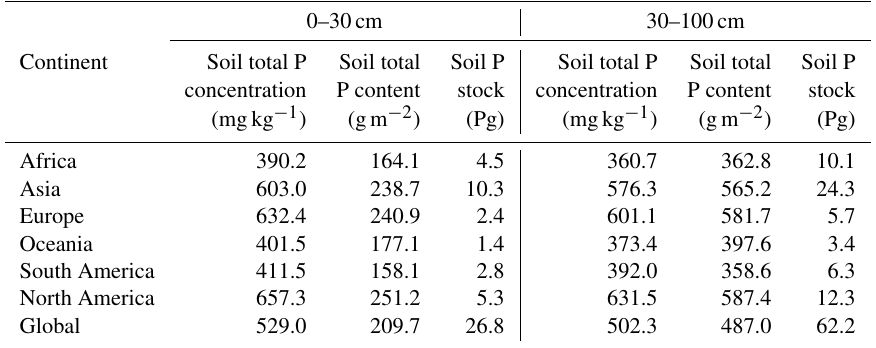
Figure 3. Results of the random forest model predicting soil total P concentration. (a) The relative importance of predictors in the model. (b) Predicted vs. observed soil total P concentration; the dashed line indicates the 1:1 line; the blue line indicates the regression line between predicted and observed values. Table 4. Analysis of the predicted global map of soil total P. The area-weighted average soil total P concentration was calculated based on our predicted map. Converting soil total P concentration to soil total P content and stock used the soil bulk density (Hengl et al., 2017b) and land